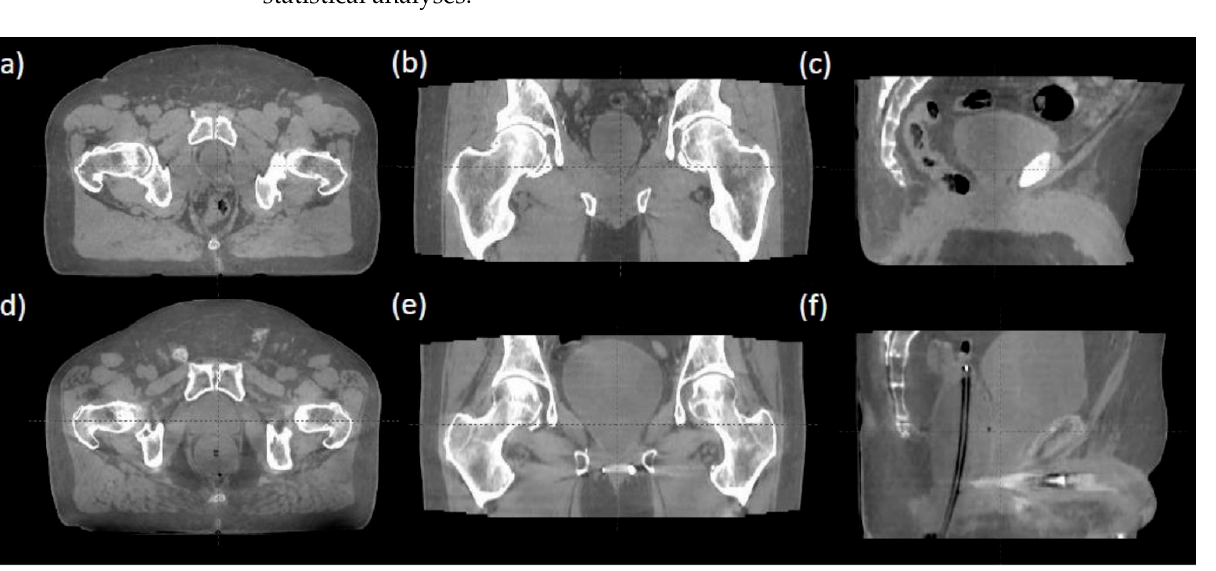
Figure 2. ( a – c ) iCBCT reconstruction of a patient without endorectal balloon. ( d – f ) iCBCT reconstruction of a patient with endorectal balloon.